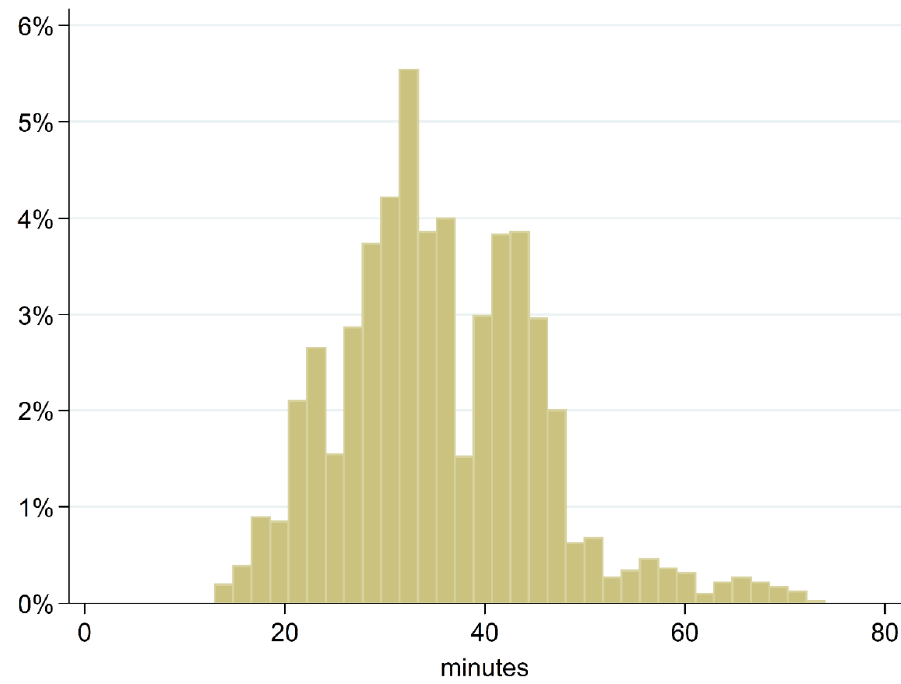
Figure 7. Distribution of travel times to the CBD.